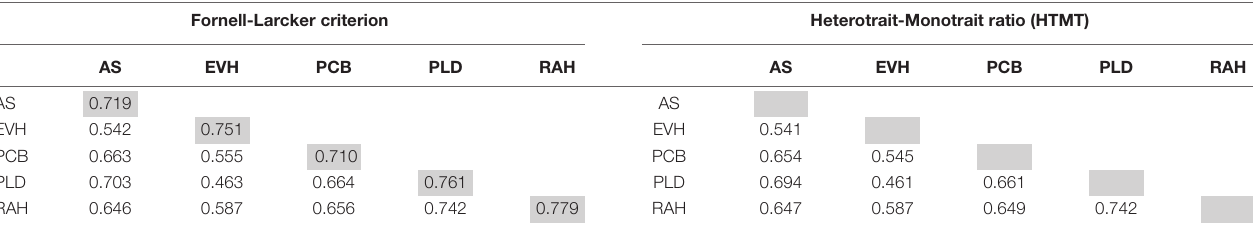
FIGURE 2 | Measurement model. TABLE 2 | Discriminant validity.